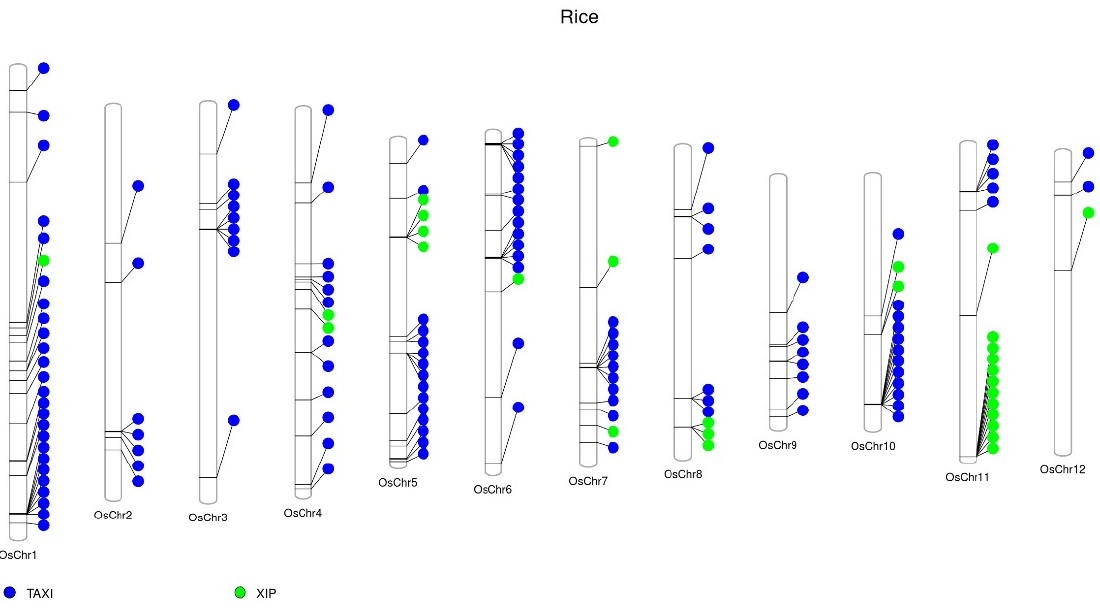
Figure 3. Distribution of xylanase inhibitors (XIs) in rice ( Oryza sativa ) chromosomes. The publicly available protein sequences of rice were downloaded from the Phytozome database